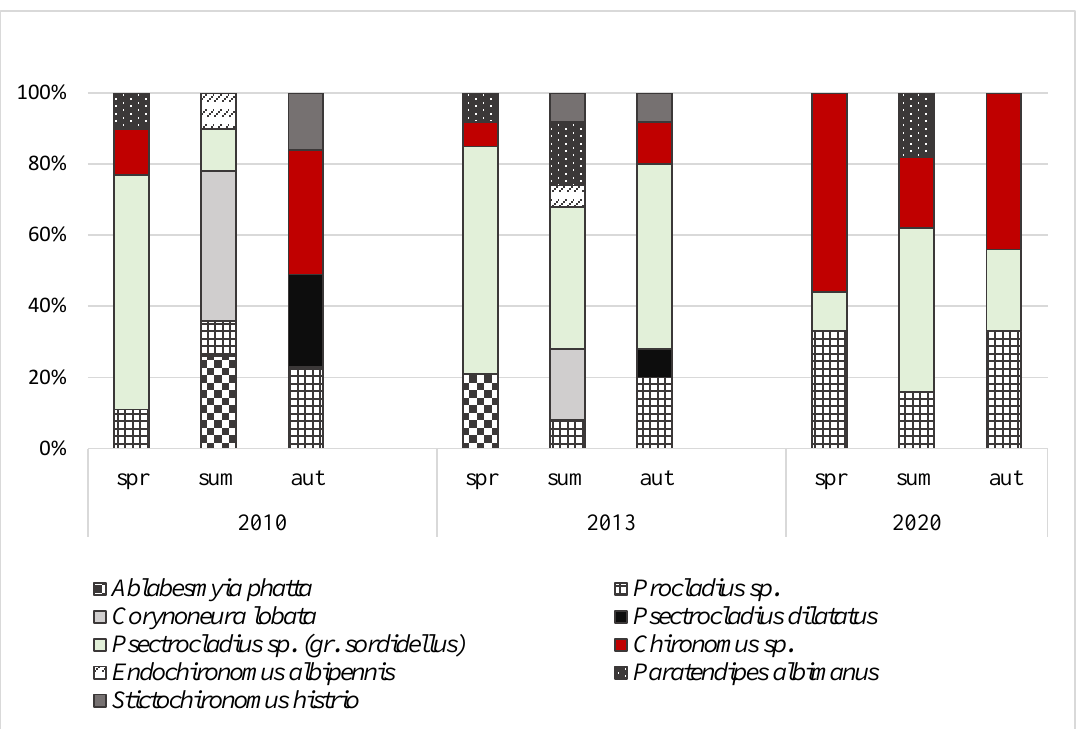
Figure 2. Changes of relative abundances of macroinvertebrate fauna in peat pool habitat during 10 years of study.